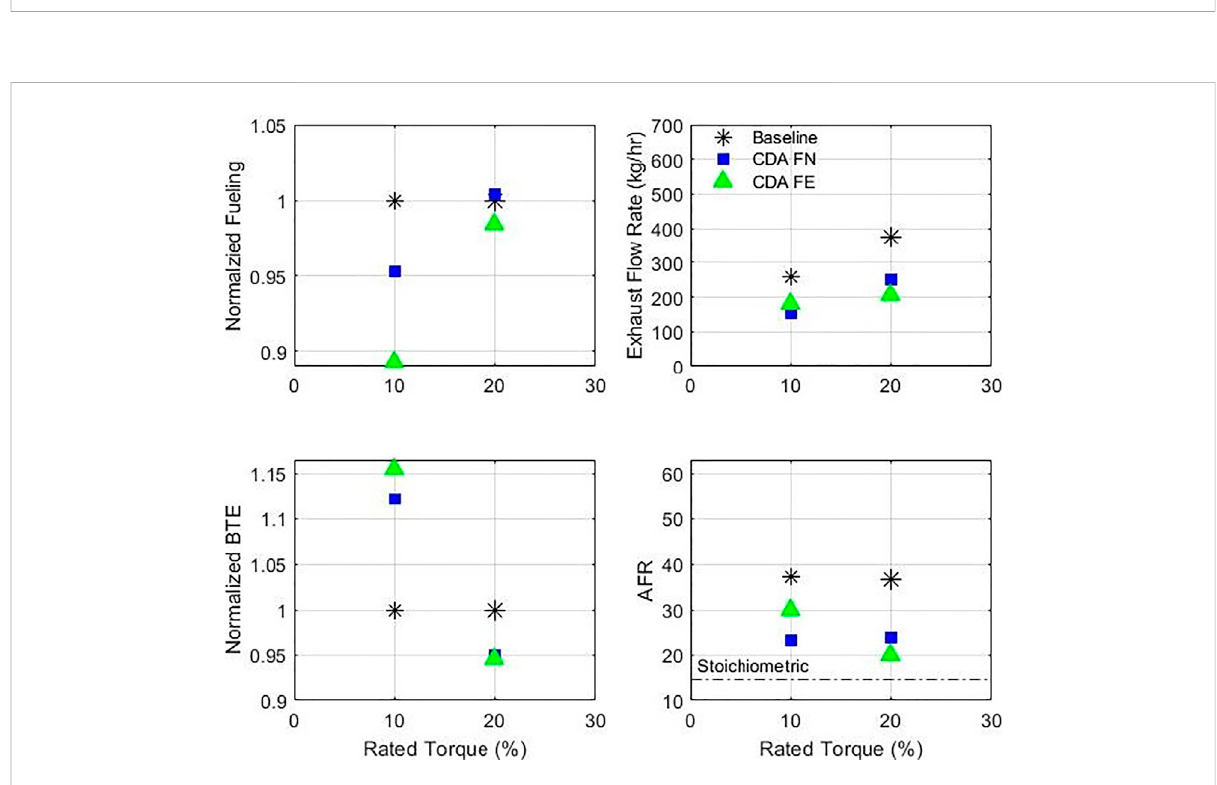
FIGURE 4 800 rpm steady state engine